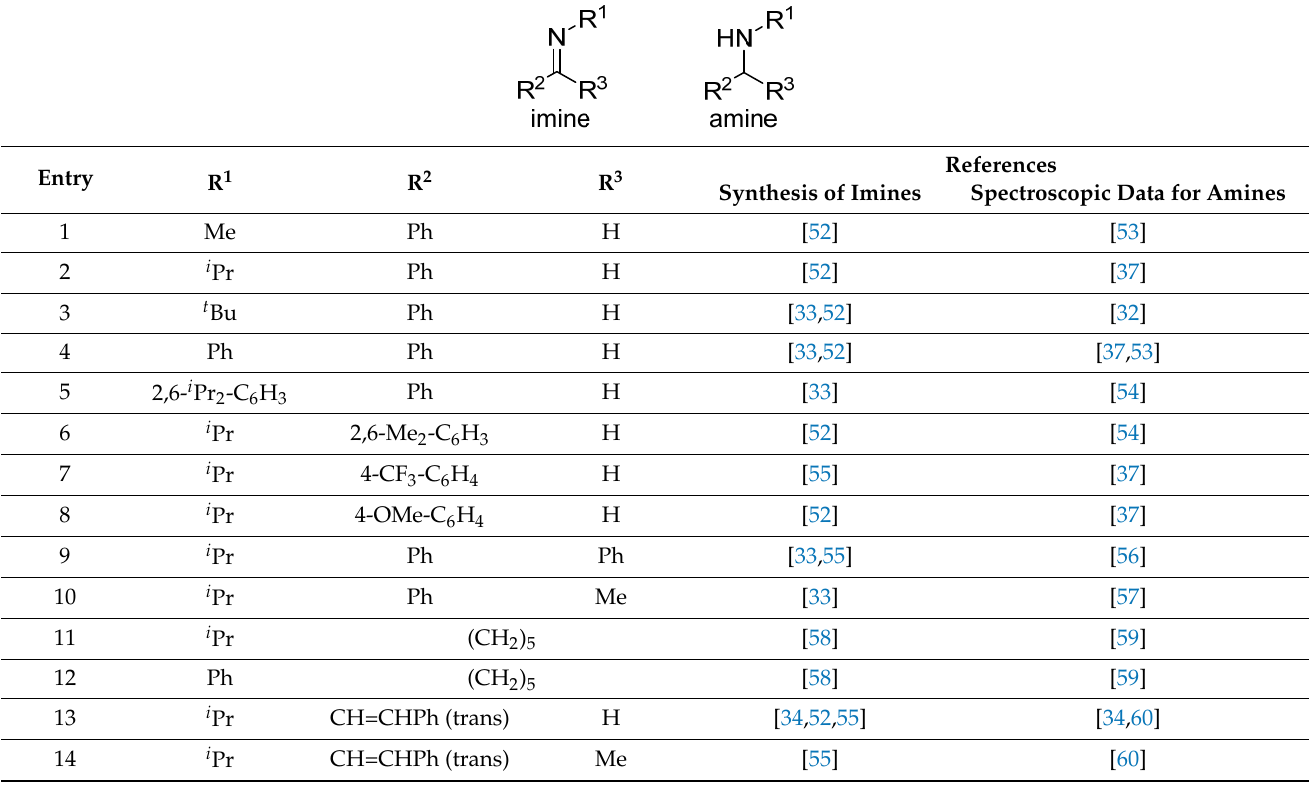
Table 2. Literature references for the synthesis of the examined imines and spectroscopic data for the corresponding amines. the corresponding amines.